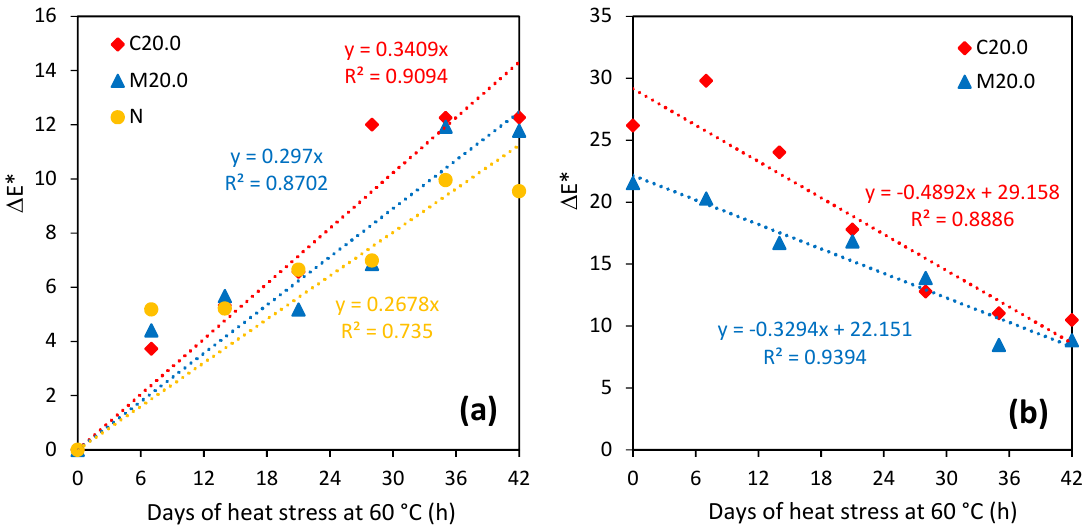
Figure 7. ( a ) Dependence of the indication charge appearance ( Δ E) on the duration of heat stress at 60 °C, and ( b ) dependence of the indication charge performance (response Δ E to 20 mg/m 3 of diphosgene) on the duration of heat stress at 60 °C.